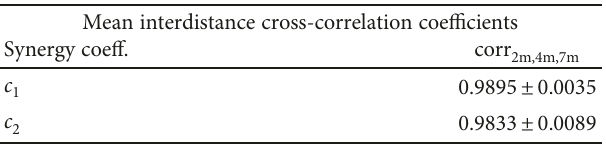
Table 5: Synergy coe ffi cients mean interdistance cross-correlation coe ffi cients. Mean interdistance cross-correlation coe ffi cients Synergy coe ff